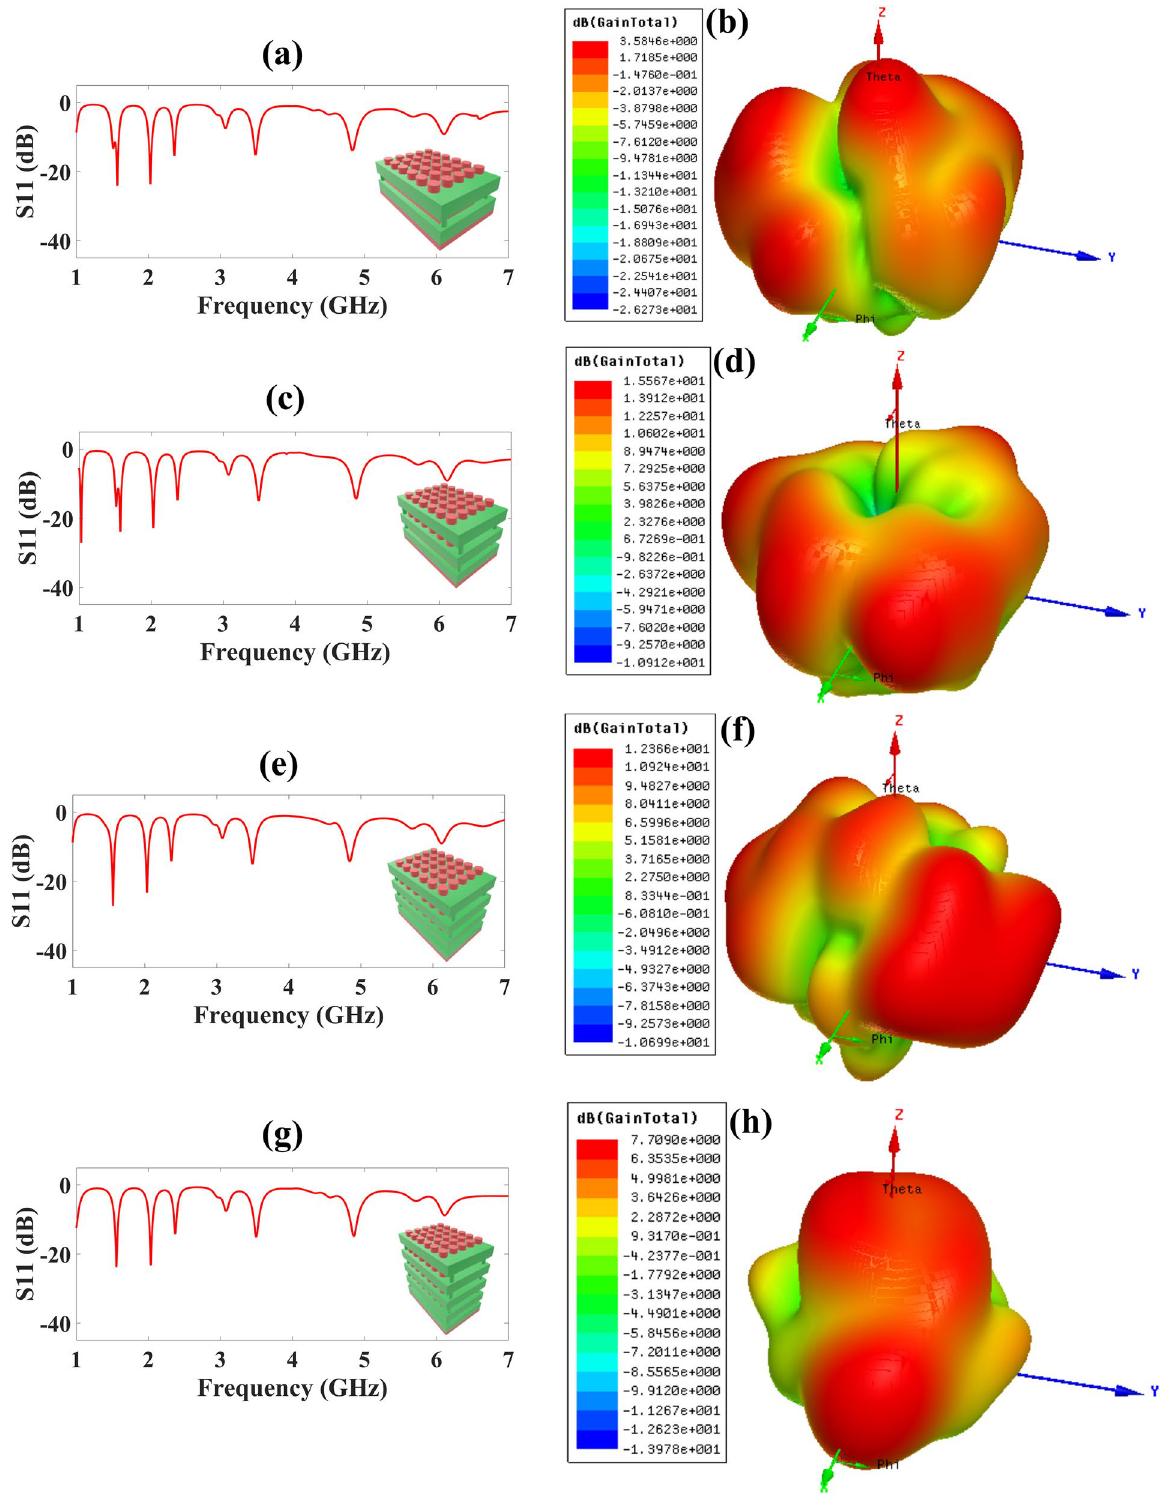
Figure 3. Simulated results of reflectance response (S 11 ) and 3D Gain polar plot for various superstrate structures (a) for 6 × 5 TW single layer superstrate structure, five frequency bands are attained, (b) 6 × 5 TW single layer superstrate structure with gain 3.58 dB, (c) for 6 × 5 TW double layer superstrate structure, six frequency bands are attained, (d) 6 × 5 TW double layer superstrate structure with gain 15.57 dB, (e) for 6 × 5 TW triple layer superstrate structure, five frequency bands are attained, (f) 6 × 5 TW triple layer superstrate structure with gain 12.37 dB, (g) for 6 × 5 TW four layer superstrate structure, 5 frequency bands are attained. (h) 6 × 5 TW four layer superstrate structure with gain 7.71